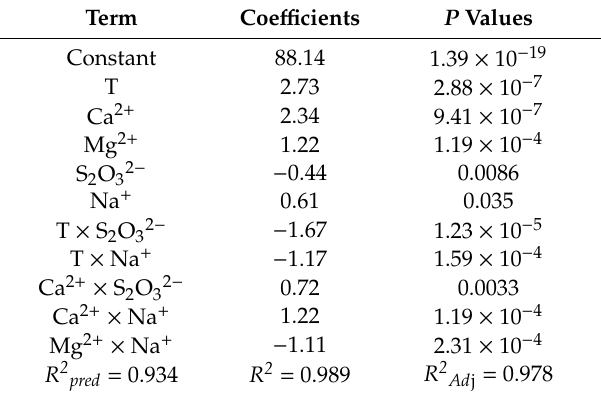
Table 4. Final regression coe ffi cients for collector adsorption on